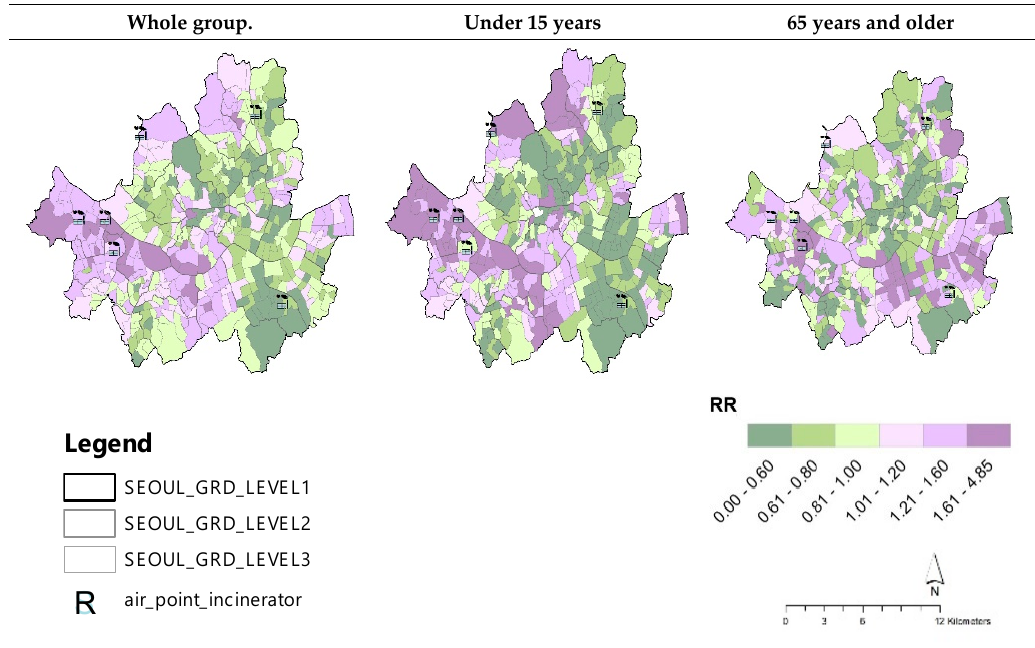
Figure 2. ISRR of Asthma-related Admissions by Age for each dong, Seoul (2009–2011).